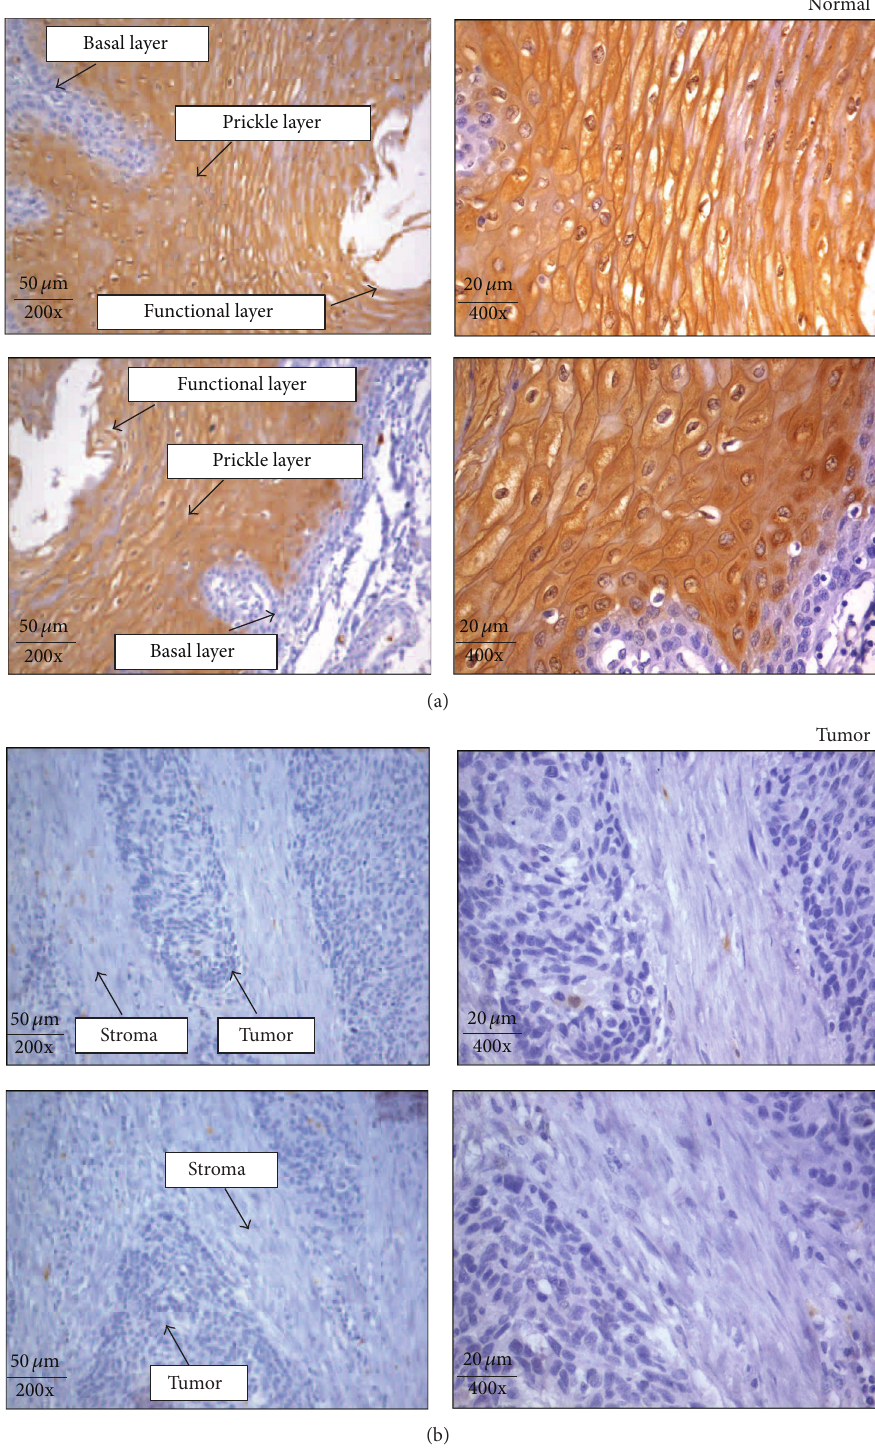
Figure 2: Expression of S100 calcium binding protein A9 in normal esophageal squamous epithelium and ESCC. (a) Expression of S100A9 in representative normal esophageal squamous epithelium where the expression of S100A9 (brown color) was limited to the differentiated prickle and functional layers, with no expression in the regenerative basal layer. Immunostaining pattern was cytoplasmic and nuclear. (b) Expression of S100A9 in ESCC tissue sections. S100A9 expression was undetectable in the majority of tumor cells and stroma. All the images were acquired at 200x and 400x magnification. Scale bars = 50 𝜇 m and 20 𝜇